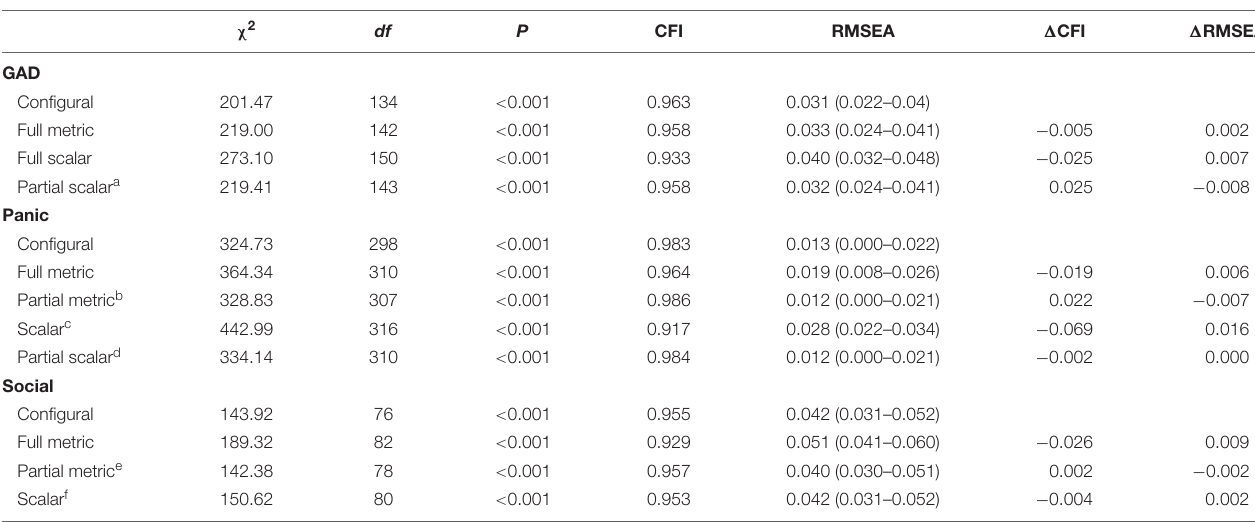
GAD, generalized anxiety disorder symptoms; panic, panic disorder symptoms; and social anxiety, social anxiety symptoms. Changes in CFI and RMSEA are calculated as differences between the metric invariance model relative to the configural invariance model and between the scalar invariance model relative to the metric invariance model. The model with best statistical fit is highlighted in bold. a In this model, two of nine threshold parameters were constrained to be equal. This model is compared to the full-metric model. b In this model, 10 of 13 factor loading parameters were constrained to be equal. This model is compared to the configural invariance model. c In this model, 3 of 13 threshold parameters were freely estimated across time. This model is compared to the partial metric model. d In this model, 4 of 13 threshold parameters were constrained to be equal. This model is compared to the partial metric model. e In this model, three of seven factor loading parameters were constrained to be